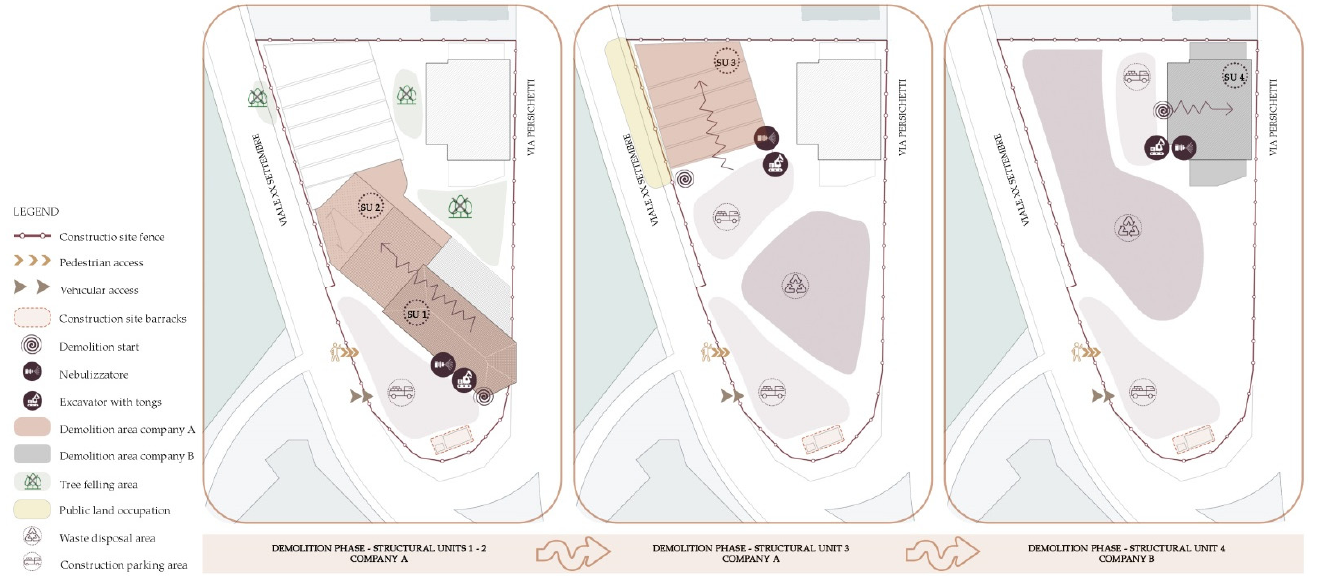
Figure 3. Demolition’s layouts—Case study.